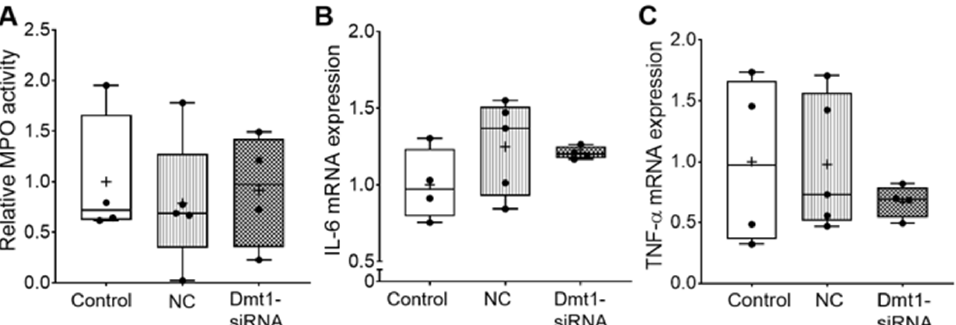
Figure 4. Inflammatory biomarkers did not change after treatments. MPO activity in duodenal epithelial tissue was measured ( A ). IL-6 mRNA expression ( B ) and TNF- α mRNA expression ( C ) in liver were also analyzed. Data are presented as box plots for n = 4–5 mice per group. No statistically significant differences were noted between groups (as determined by one-way ANOVA). NC, negative control; + , mean value.